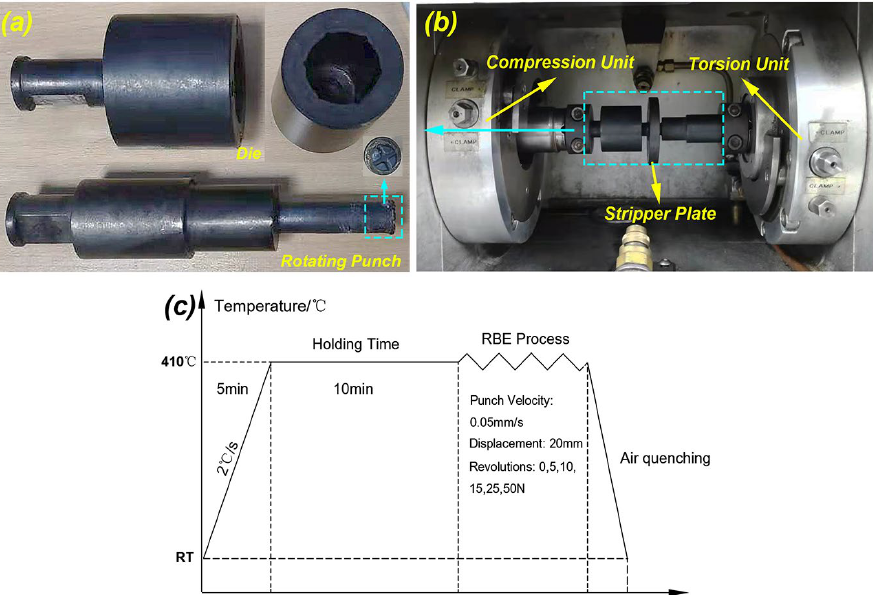
Figure 2. ( a ) The die structure, ( b ) experimental equipment, and ( c ) specific processing procedure and parameters for applied RBE method.